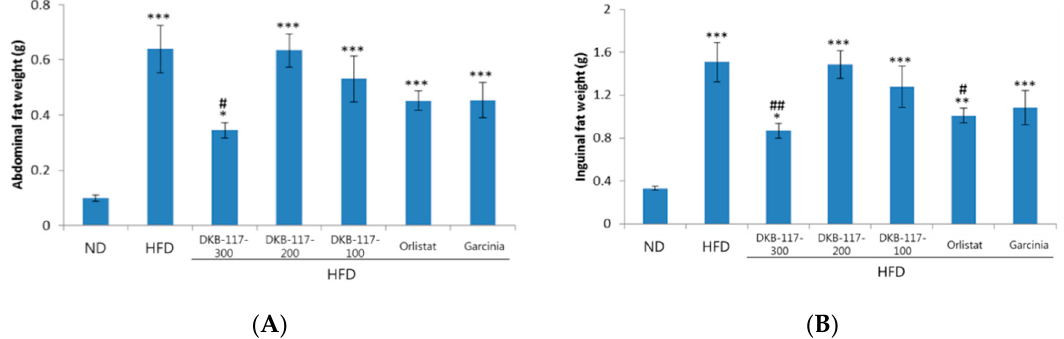
Figure 3. Effect of DKB-117 extracts on ( A ) abdominal and ( B ) inguinal fat weight in HFD-induced obese mice. The values are presented as means ± SEMs. ***/**/* A significant difference at the p < 0.001/ p < 0.01/ p < 0.05 level versus the ND. ##/# A significant difference at the p < 0.01/ p < 0.05 level versus the HFD. ND, normal diet control group; HFD, high-fat diet control group; DKB-117-300, DKB-117 300 mg/kg; DKB-117-200, DKB-117 200 mg/kg; DKB-117-100, DKB-117 100 mg/kg; Orlistat, orlistat 40 mg/kg; Garcinia, Garcinia cambogia 200 mg/kg.